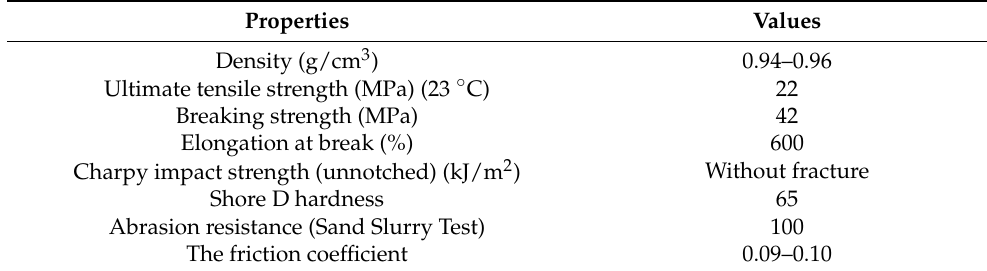
Table 10. The properties of the materials fabricated by ‘Guangzhou Engineering Plastics’ [43].